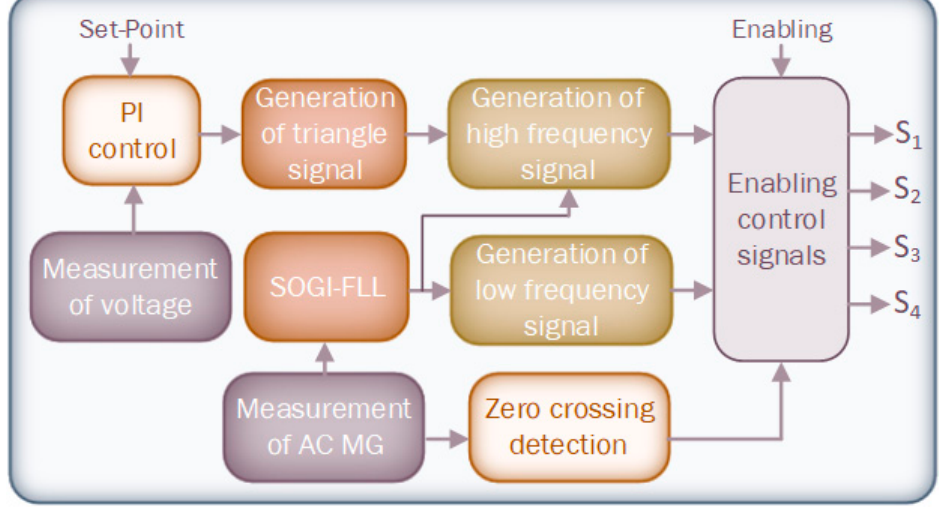
Figure 12. Control algorithm diagram for inverter.